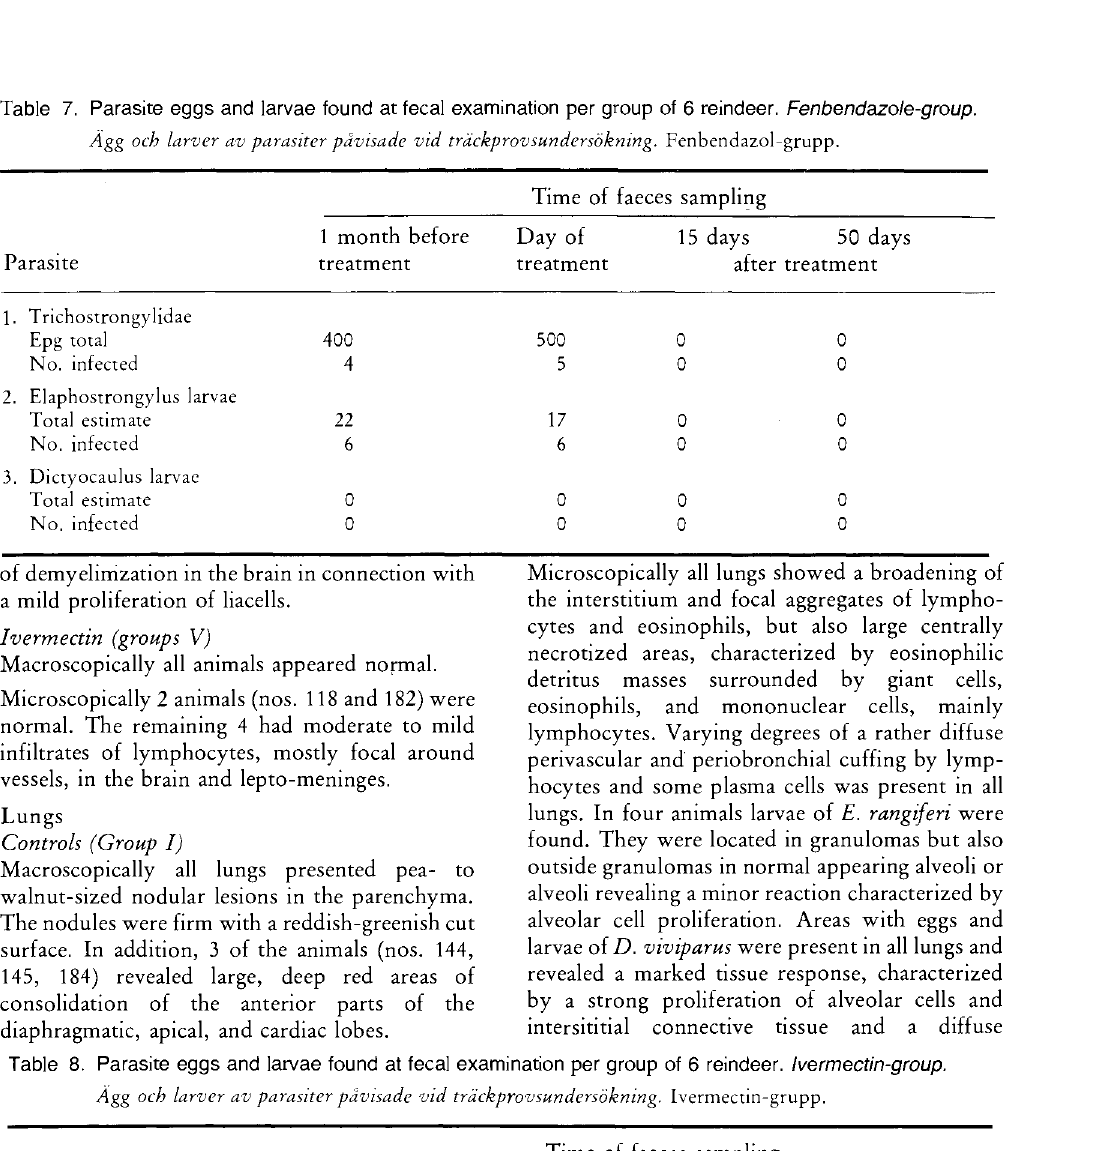
Table 7. Parasite eggs and larvae found at fecal examination per group of 6 reindeer. Fenbendazole-group.